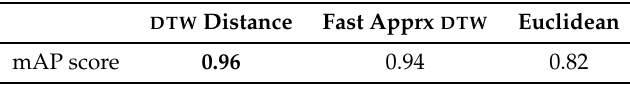
Table 1. The comparison of the performance of DTW distance, Fast Apprx DTW and Euclidean distance as a similarity measure for a word retrieval